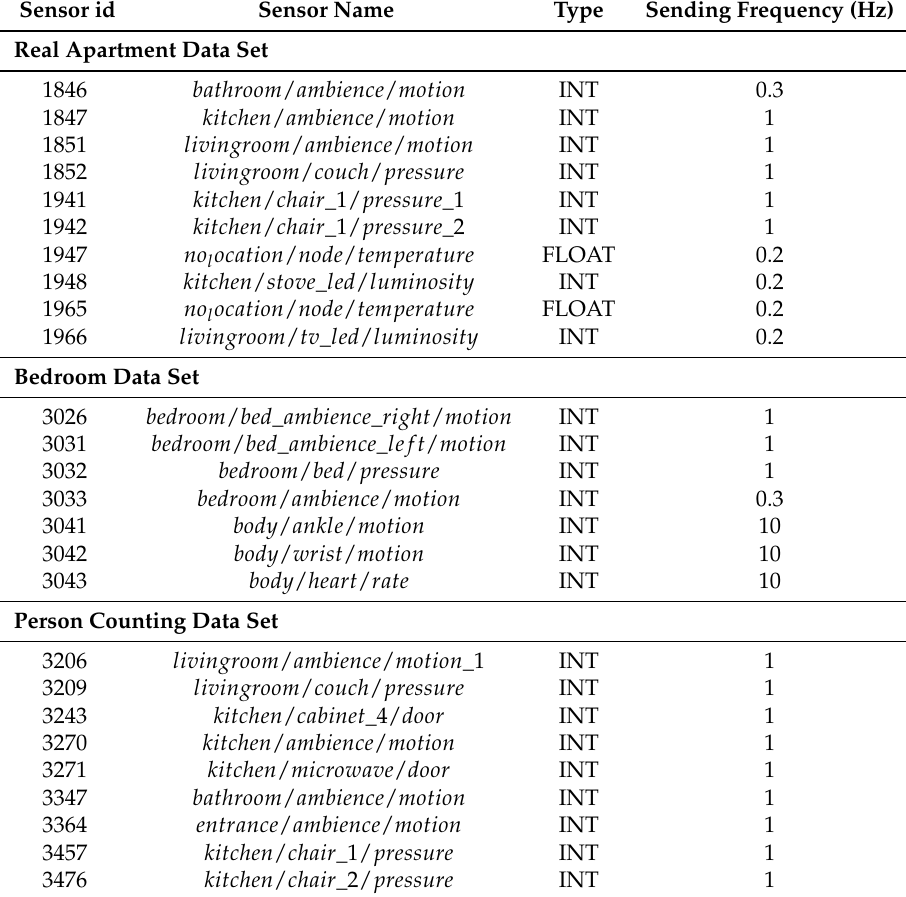
Table 1. The sensors used for the different scenarios: The two temperature sensors (id 1947 and 1965) are two different sensors located in the main body of the apartment and measure the same